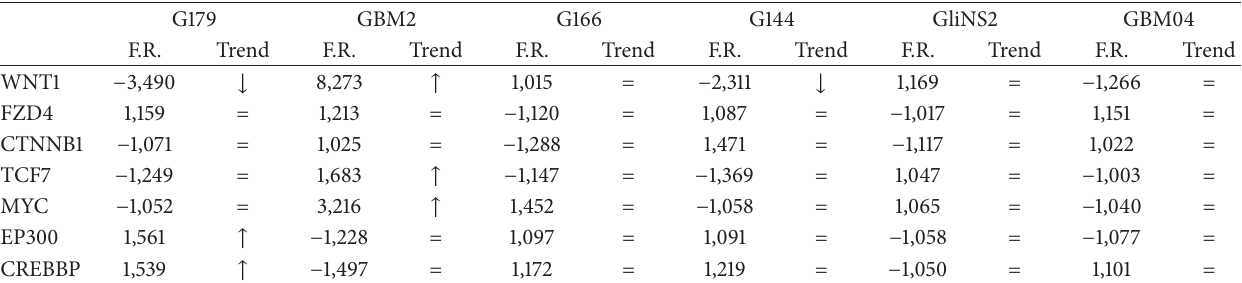
Table 2: Fold regulation and trend of the expression variations of 7 Wnt pathway-focused genes in response to Pio treatment. G179 GBM2